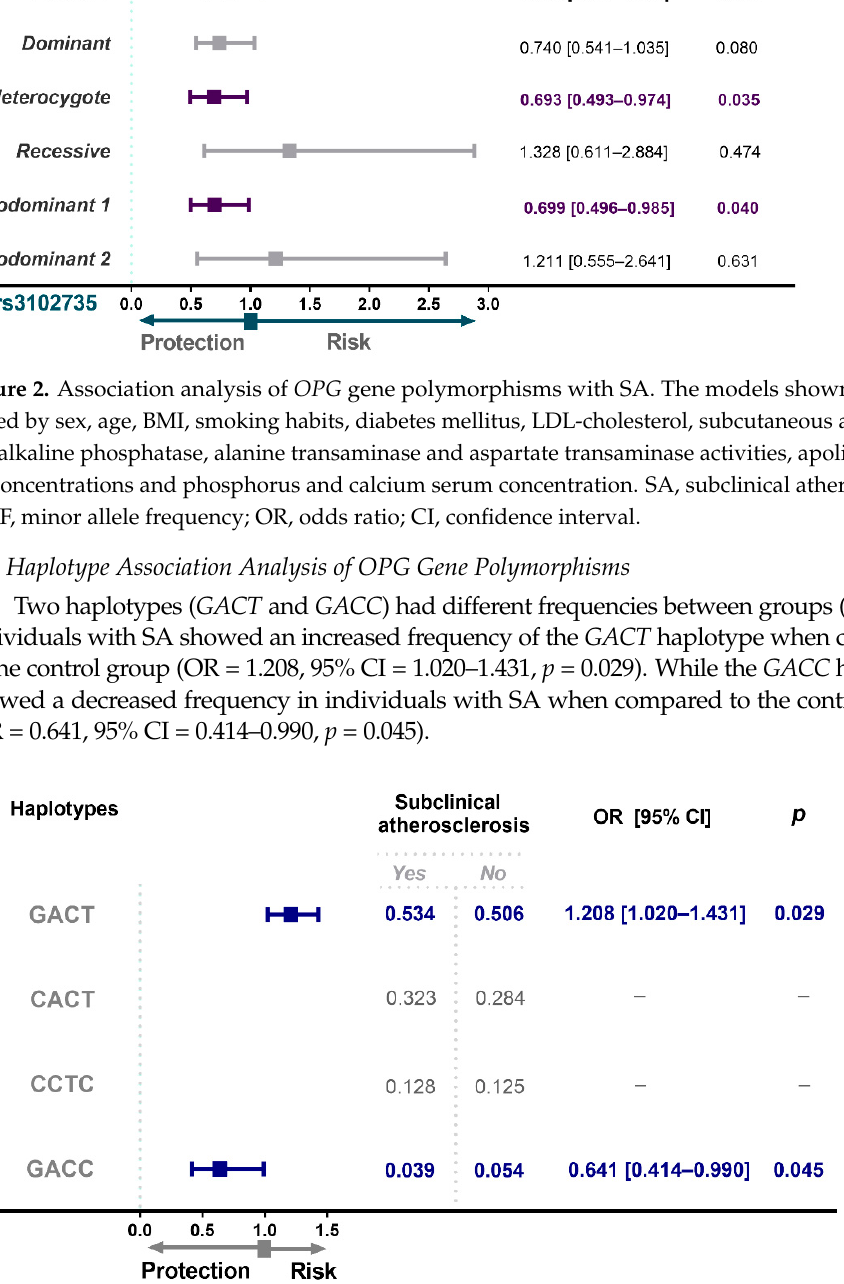
Figure 3. OPG haplotype frequencies in individuals with subclinical atherosclerosis. Haplotype analysis was performed based on the order and position of the polymorphisms in the chromosome. (rs2073618, rs3134069, rs3134070, rs3102735). OR, odds ratio; CI, confidence interval.